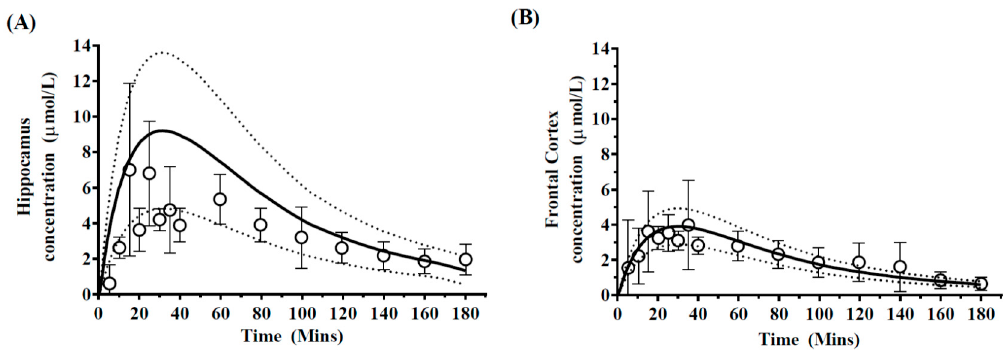
Figure 5. Simulated mean phenytoin hippocampus and frontal cortex concentration–time profiles. Simulated mean values of phenytoin-time profiles in ( A ) hippocampus and ( B ) frontal cortex after a 50 mg/kg dose of phenytoin. Open circles and errors bars represent literature reported mean and ± SD in 5 rats. The solid black line represents model prediction mean profiles and dashed lines indicated 95th and 5th percentiles.